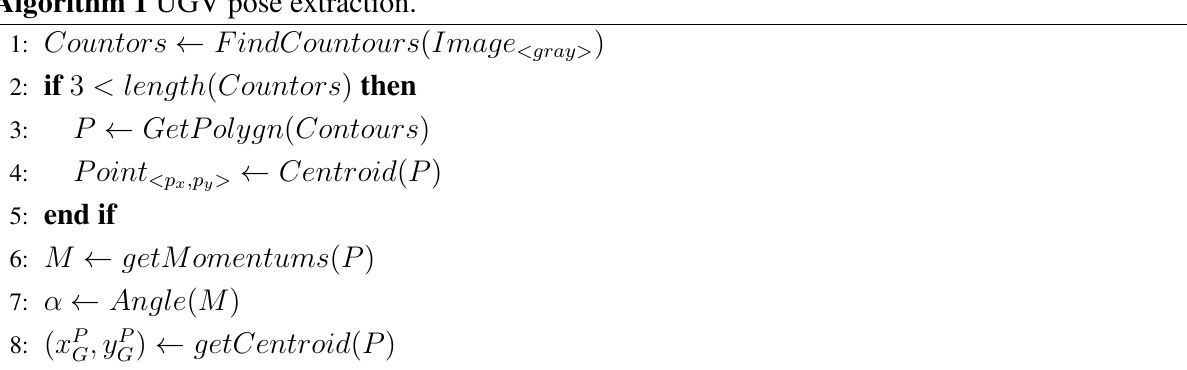
Algorithm 1 UGV pose extraction.